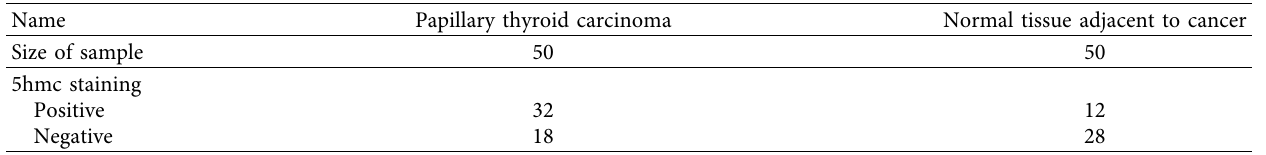
Table 2: Statistics of hydroxymethylation 5hmc staining results ( n �